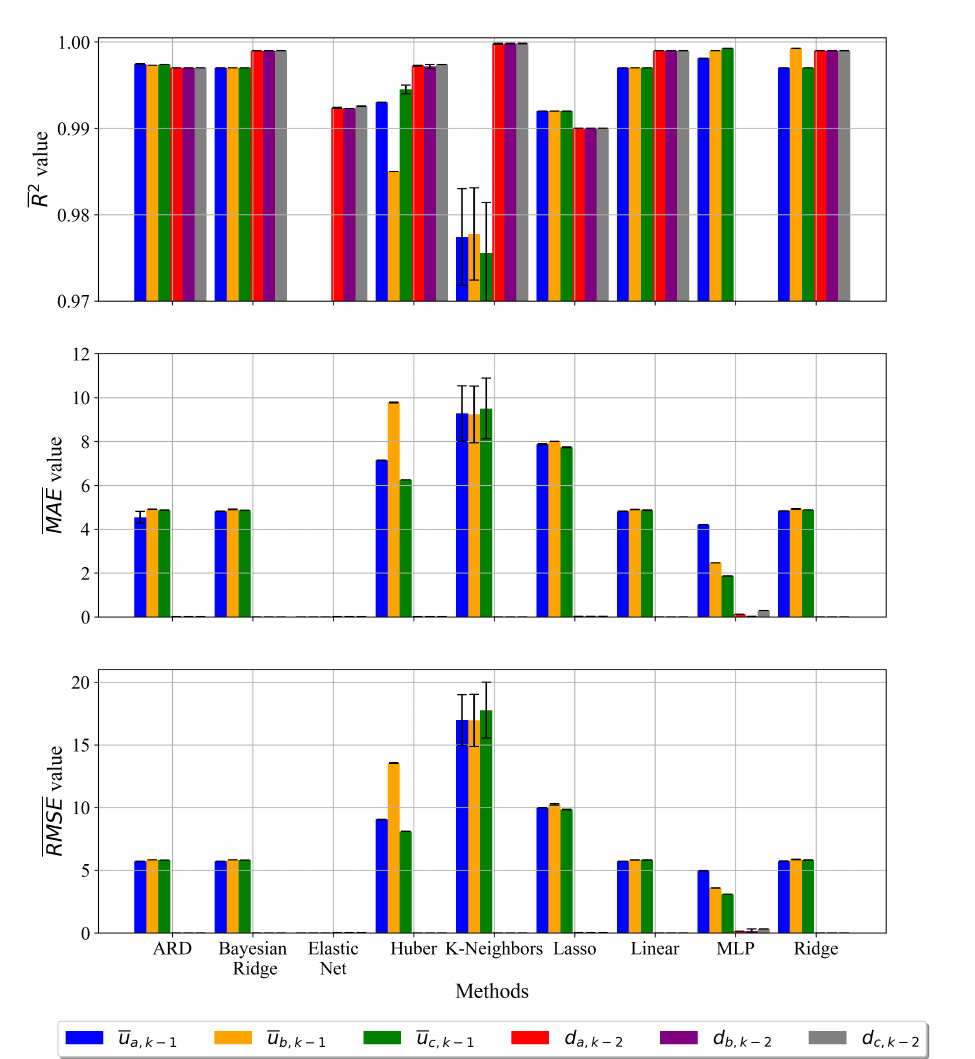
Figure 9. R 2 , MAE , and RMSE values with standard deviation shown as error